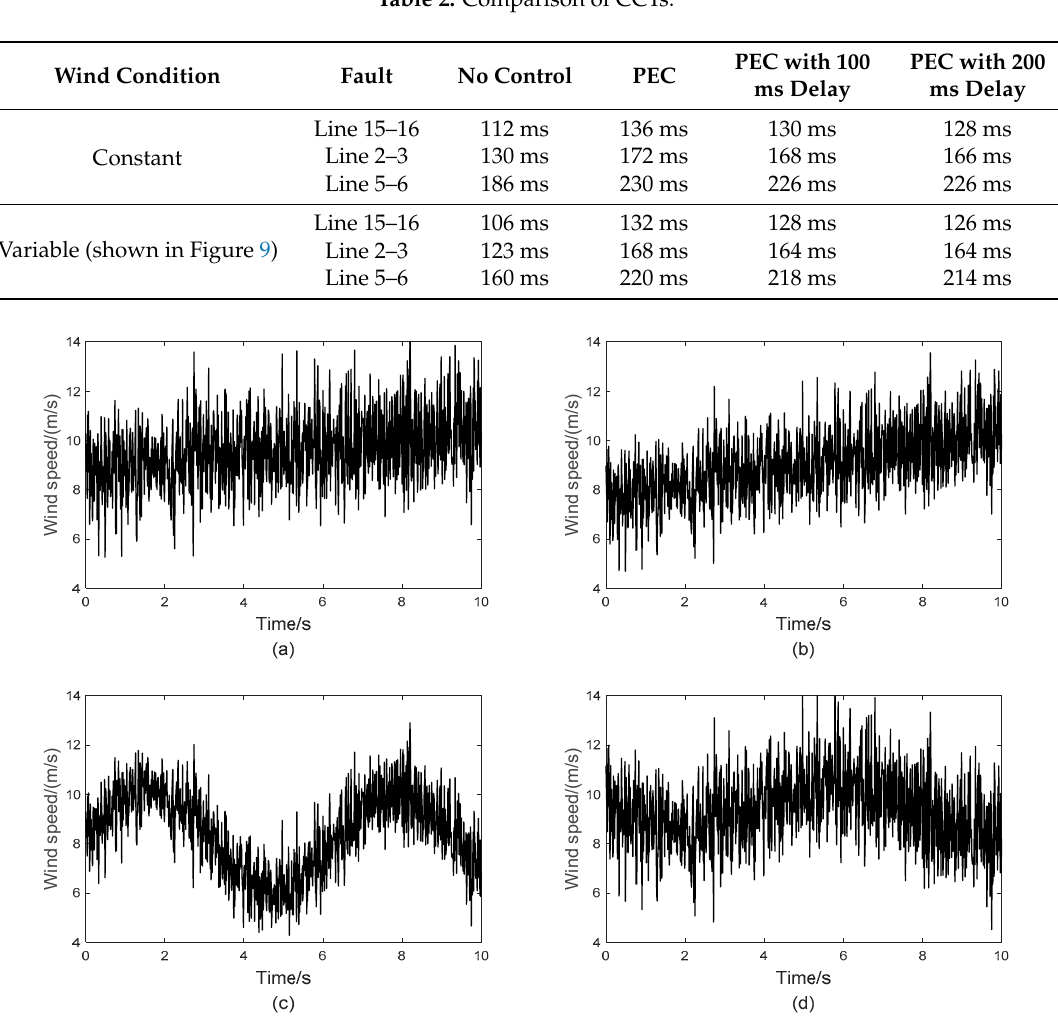
Table 2. Comparison of CCTs.